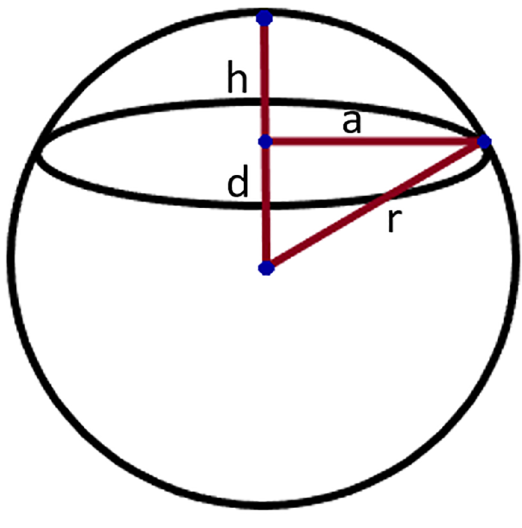
Figure 1. Scheme for quantifying wear volumes of counter-bodies.